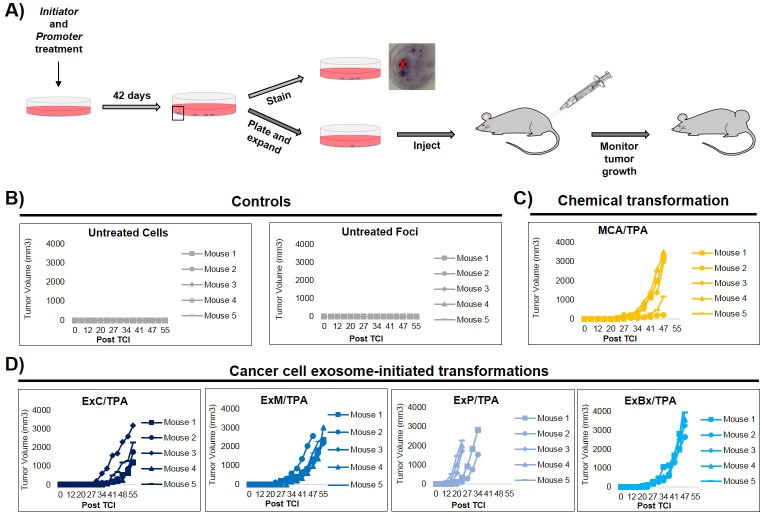
In vivo studies confirm the fully transformed form of cancer cell exosome-initiated cells.(A) In vivo assay. NIH/3T3 cells are treated with an initiator and promoter according to the cell transformation assay (42 days total). At the end of the transformation experiment, prior to methanol fixation and staining with crystal violet, foci were isolated, expanded, and established as a transformed cell line. Transformed cells are then subcutaneously injected into mice to monitor for tumor formation. Tumor growth was tracked by measuring tumor volume 2x/week for up to 55 days post injection (Post TCI) or until tumor size exceeded maximum limit. (B) Control mice include injection of untreated NIH/3T3 cells or background foci formed in untreated NIH/3T3 cells. Cells were injected at a concentration of 1 × 106 cells. Injection of untreated cells never resulted in tumor growth; injection of background foci from untreated cells resulted in tumor growth in 6 out of 15 total mice (see figure supplements for additional mice). (C) Results from injections of chemically transformed cells (MCA = initiator/TPA = promoter). Transformed cells were injected at a concentration of 1 × 106 cells. Tumor growth was observed in all mice (n = 5) from three independent experiments (see figure supplements for additional mice). (D) Results from injections of cancer cell exosome-initiated transformed cells; exosomes from four cancer cell lines, Capan-2 (ExC), MIA PaCa-2 (ExM), Panc-1 (ExP), and BxPC-3 (ExBx), were used as an initiator with the promoter TPA. Transformed cells were injected at a concentration of 1 × 106 cells. Tumor growth was observed in all mice (n = 5) for each treatment (see figure supplements for additional mice).